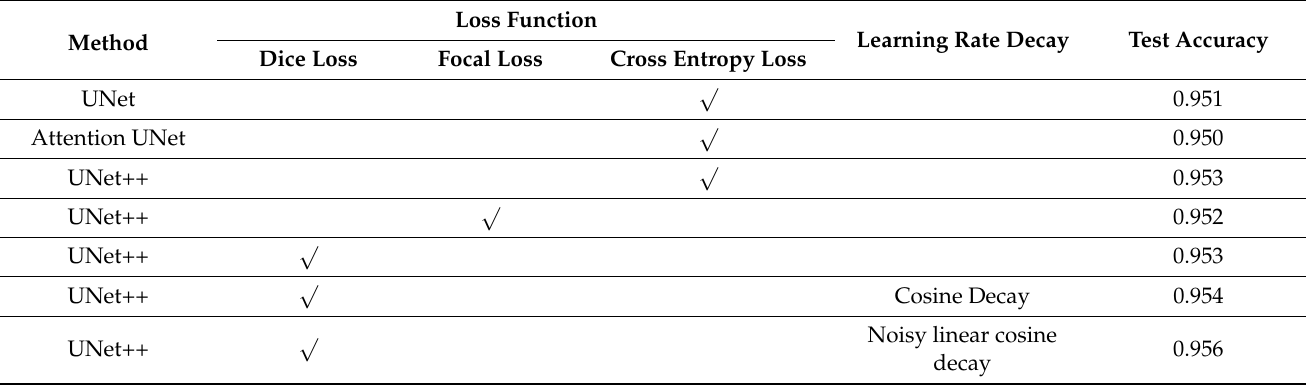
Table 1. U-net series model